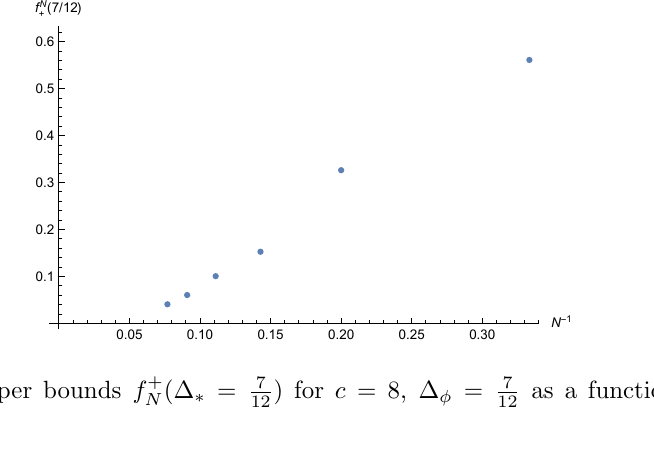
Figure 12 . The upper bounds f + derivative